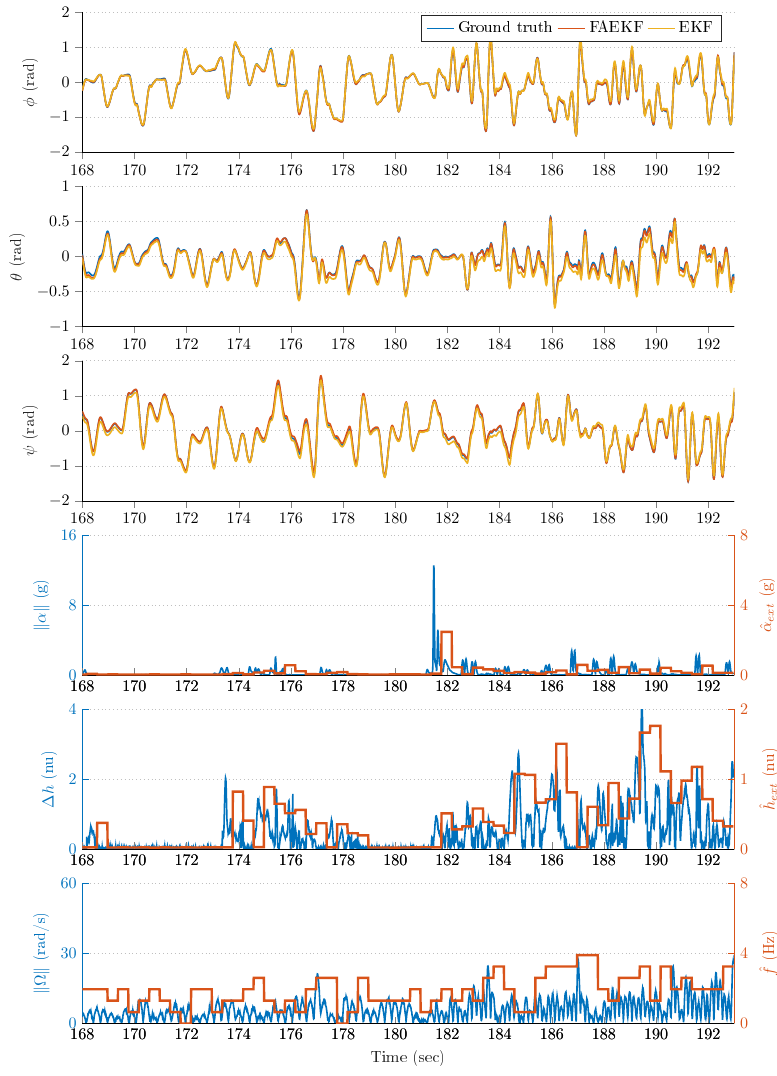
Figure 11. Fourth time slot from the